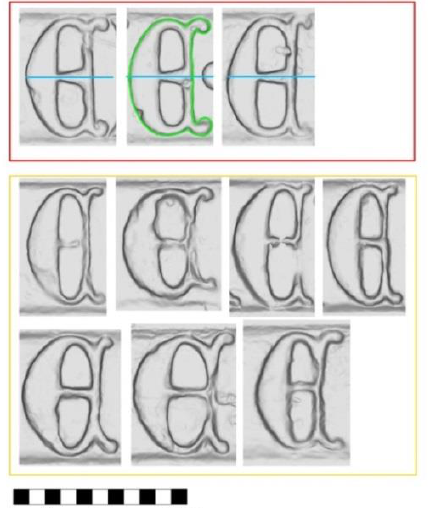
Figure 9. Letter E s: above in red frame 19 th century E s; blue: middle axis; green: mirrored parts; below in yellow frame: medieval E s.